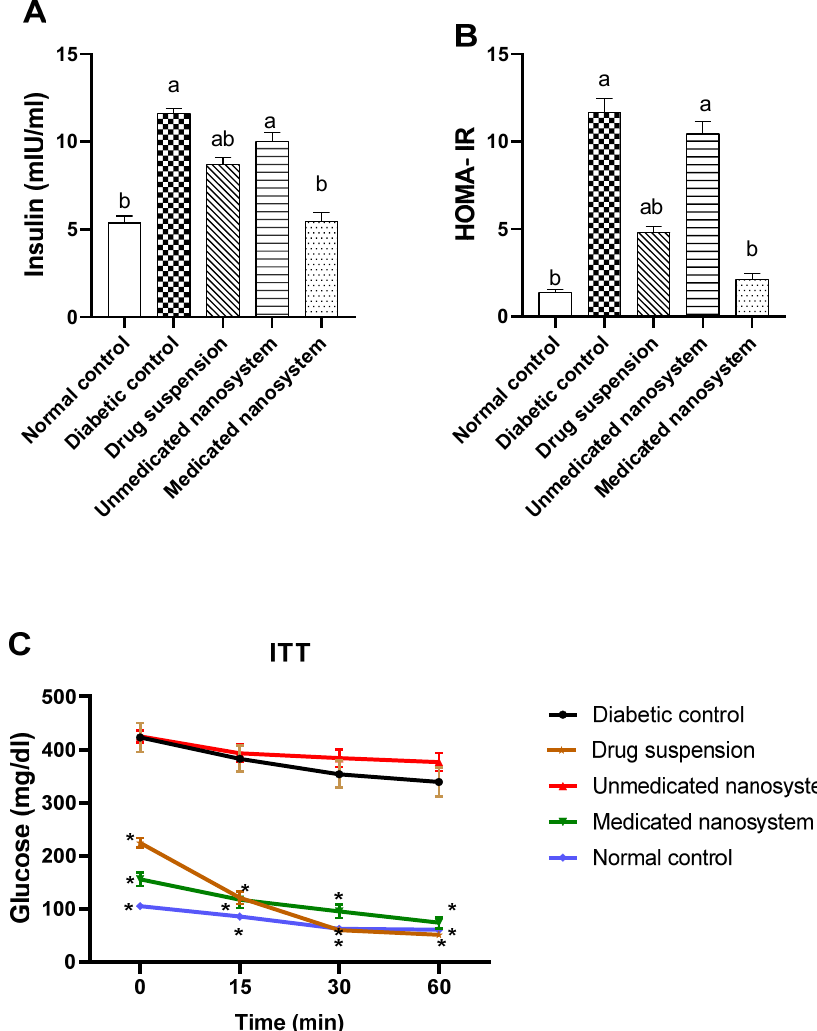
Figure 6. Effect of β -sitosterol glucoside on serum insulin ( A ), HOMA- IR ( B ), and ITT ( C ) in STZ- induced diabetic rats. Each value denotes mean ± SEM ( n = 6). Statistical analysis was carried out by one-way ANOVA followed by Tukey’s post-hoc test. a significantly different from normal control. b significantly different from diabetic control at p < 0.05. * significantly different from diabetic control at p < 0.05 for ITT.